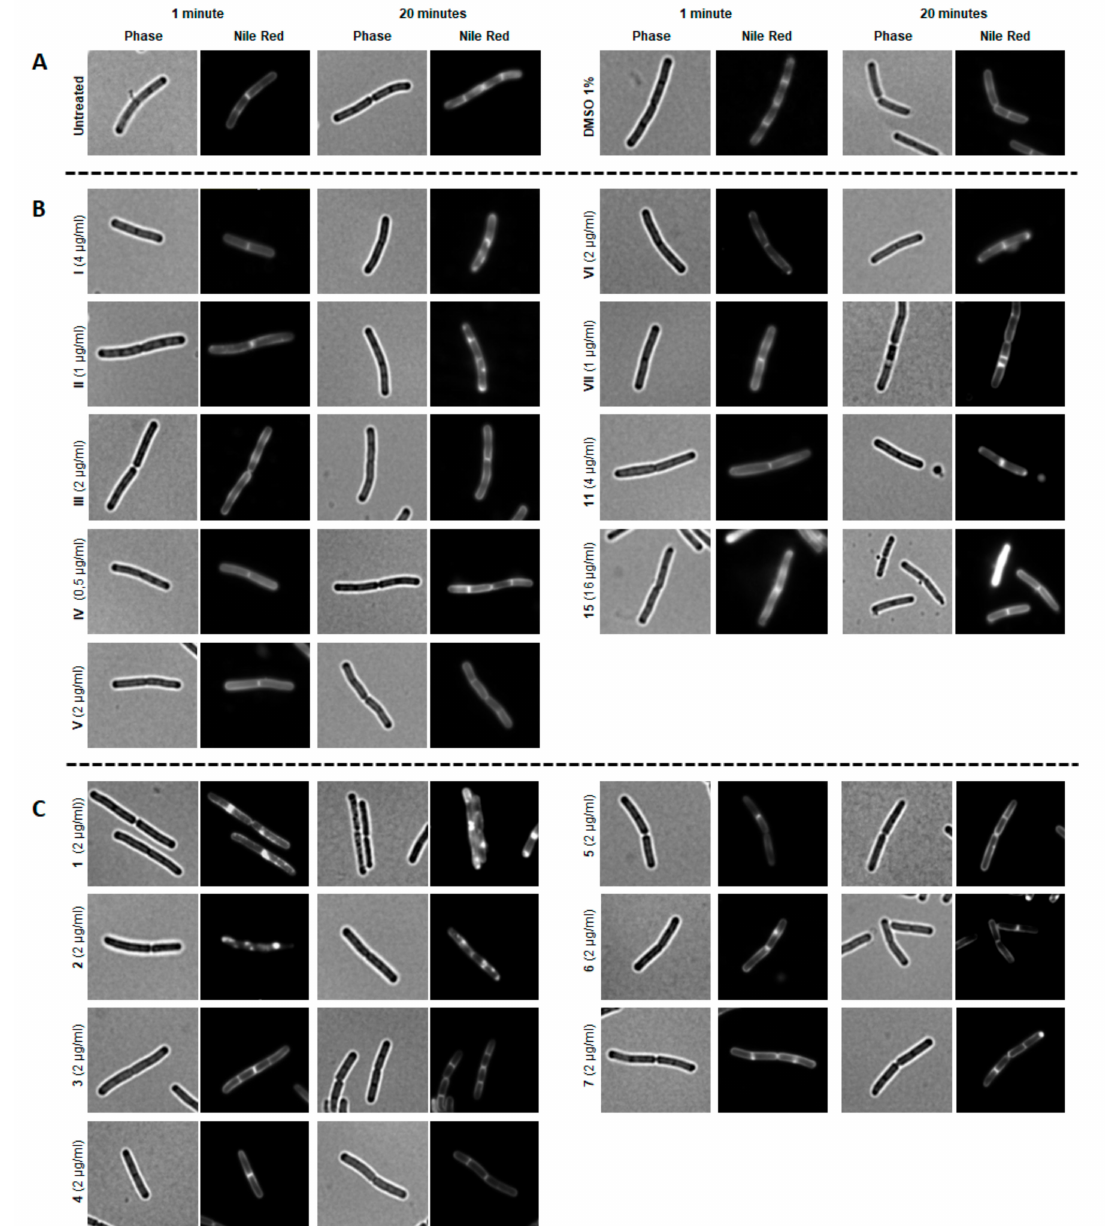
Figure 8. Microscopy images after 1 and 20 min of treatment with cationic ( B ) and Ag(I)-NHC-Ag ( C ) dendritic systems. Untreated and DMSO 1% are also depicted to control the proper growth of bacteria ( A